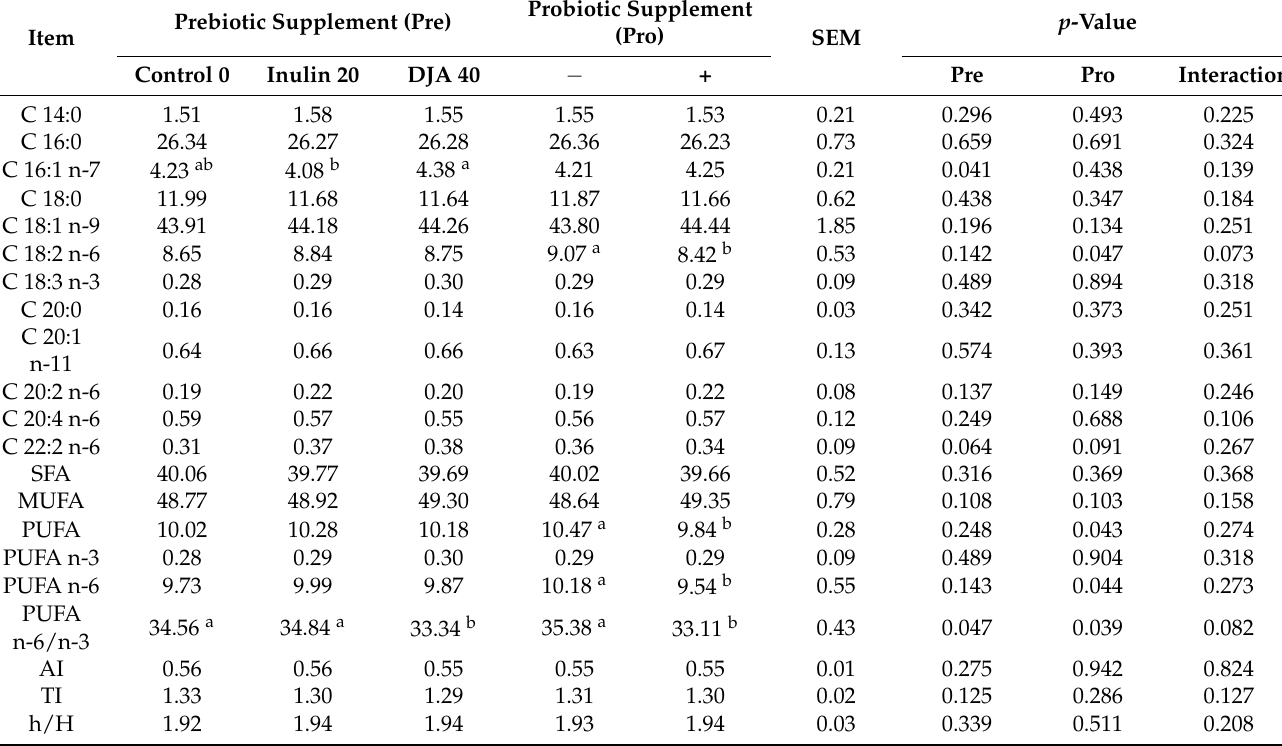
Table 8. Fatty acid composition (g per 100 g of all estimated fatty acids) in meat (m. longissimus